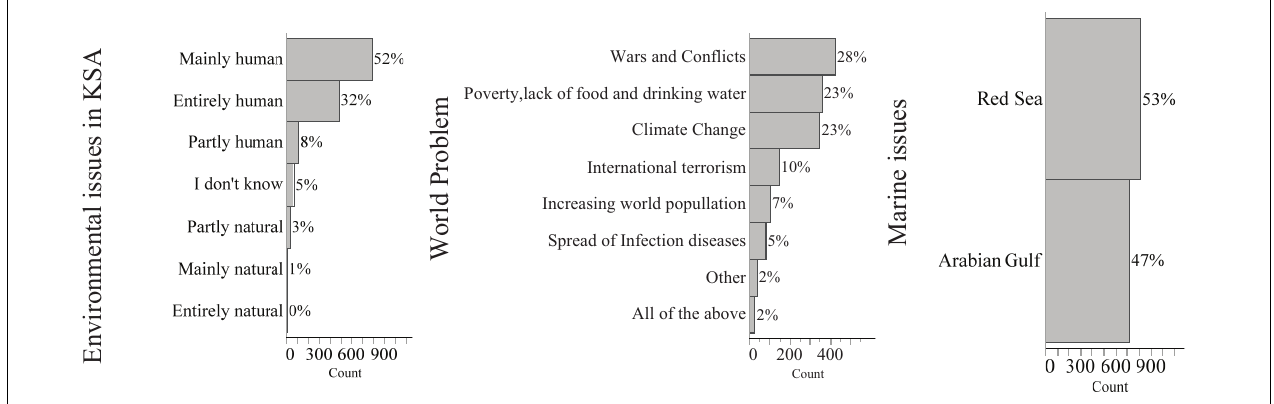
FIGURE 2 | Responses to the questions: Thinking about the causes of marine environmental issues in Saudi Arabia, which, if any, of the following best describes your opinion? In your opinion, which of the following do you consider to be the most serious problem currently facing the world as a whole? Which sea do you think suffers of more coastal marine issues?